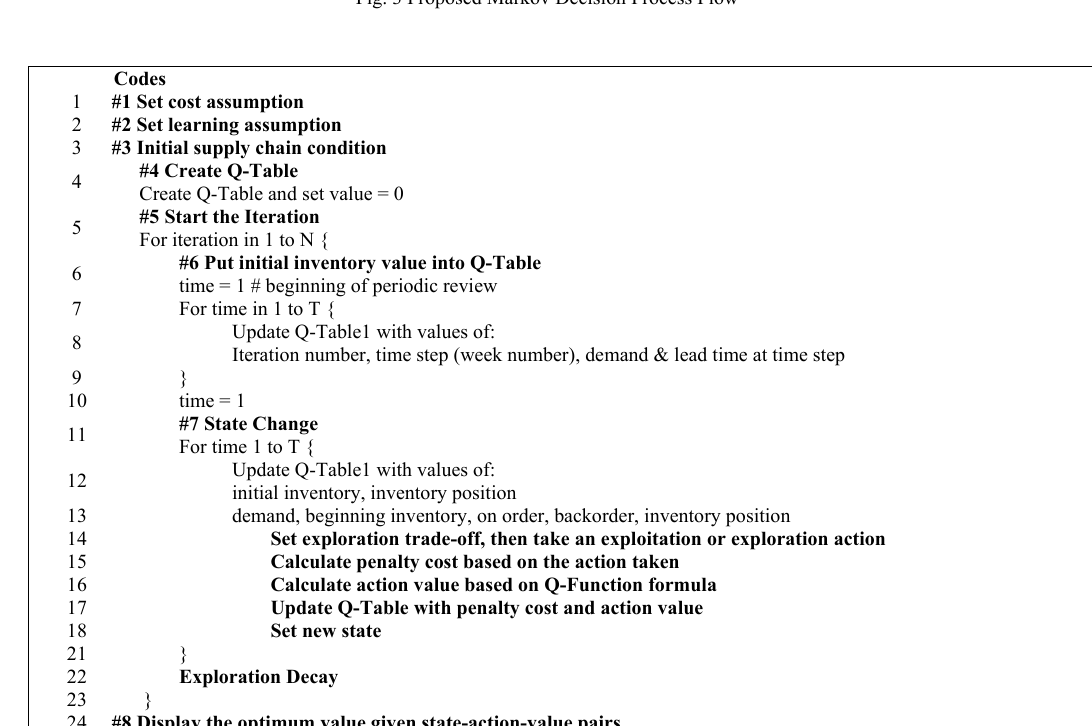
Fig. 3 Proposed Markov Decision Process Flow